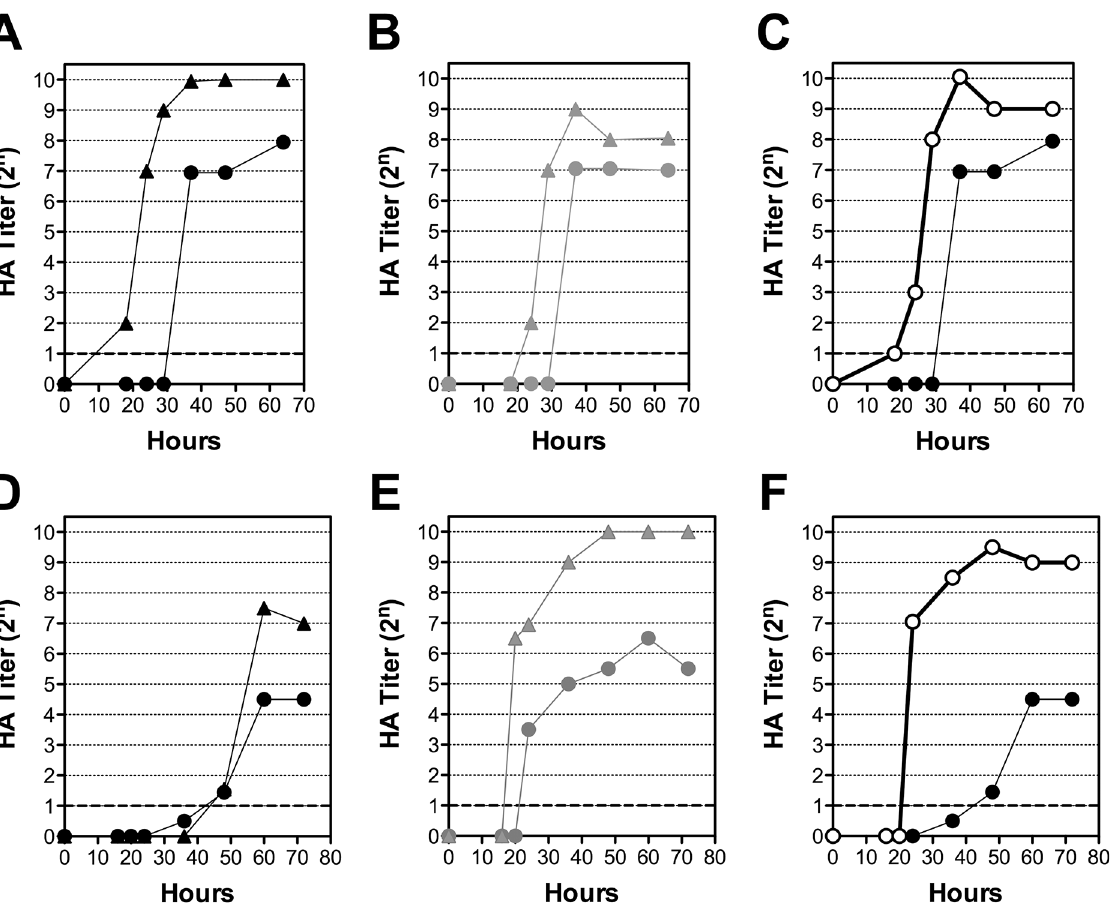
Fig 2. Growth kinetics of A/N in cell cultures or eggs after adaptation to cells, eggs, or mice. Growth kinetics of different viruses in cell culture (A – C) and chicken eggs (D – F). A and D, A/N isolated and passaged 15 times in cells; B and E, A/N isolated and passaged 15 times in eggs; C and F, virus passaged 15 times in mice. For A/N-CK and A/N-E, working stock was used. For details, please see the Materials and Methods.